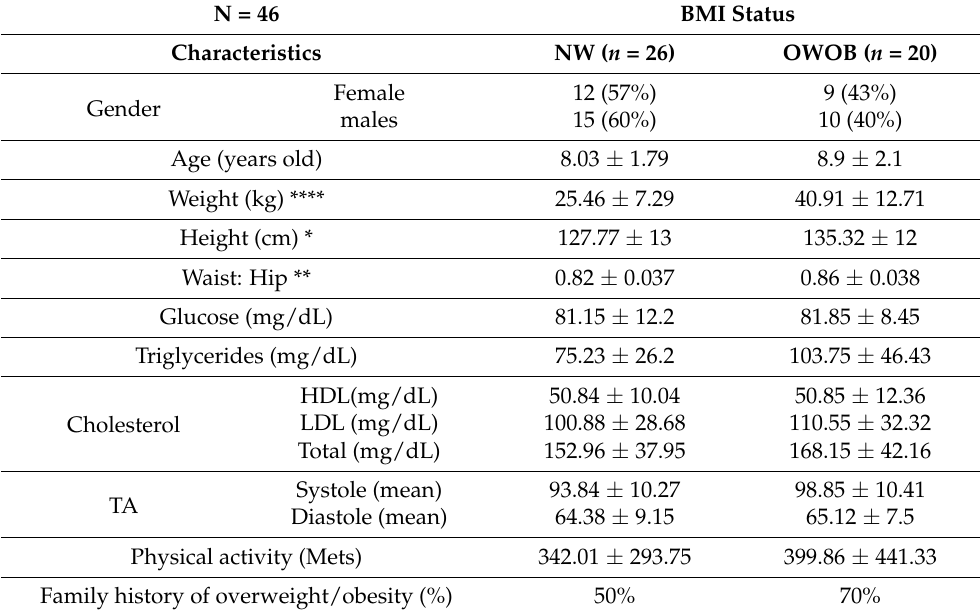
Table 1. General characteristics by BMI status of children from Mexico